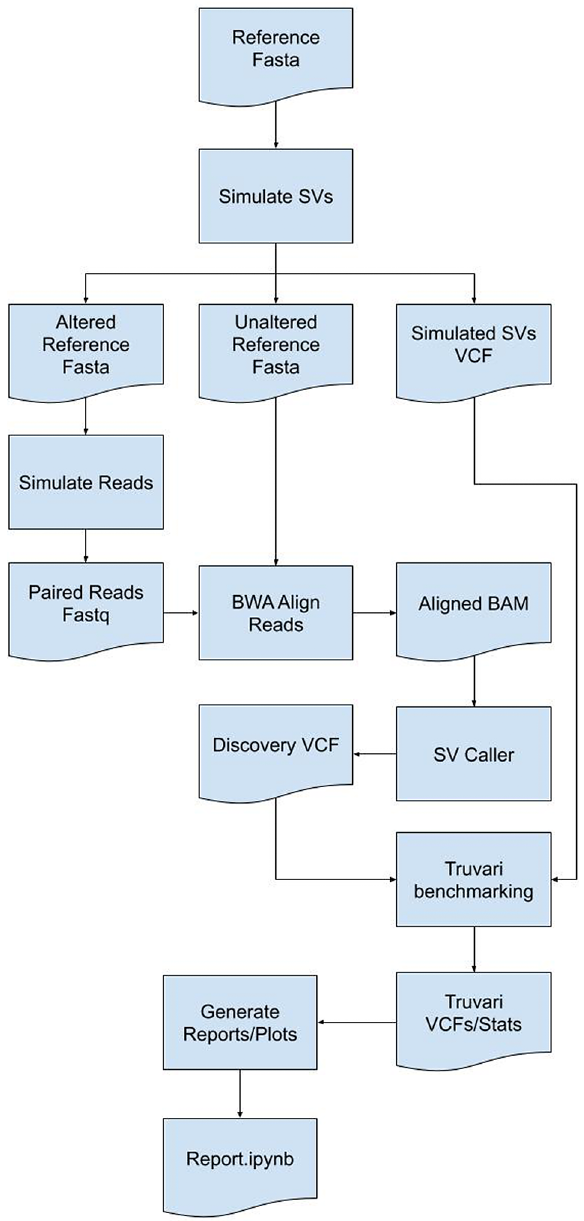
Figure 9. An illustration of the methodology implemented by the SVTeaser software package. SVTeaser software implementation showing how by using a reference genome a set of SVs can be simulated to benchmark SV calling tools to inform experimental design decisions prior to